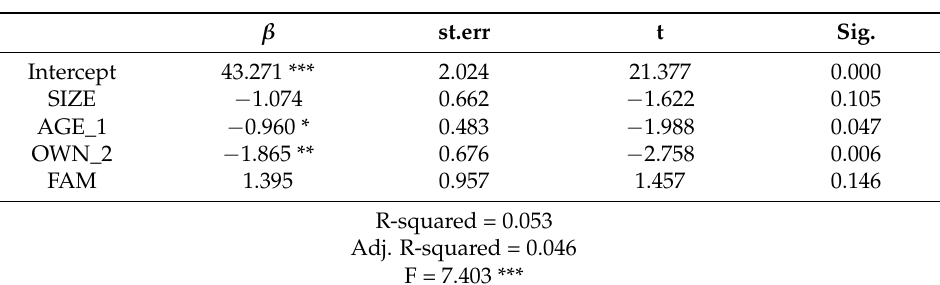
Table A4. OLS regression results for consolidated COVID-19